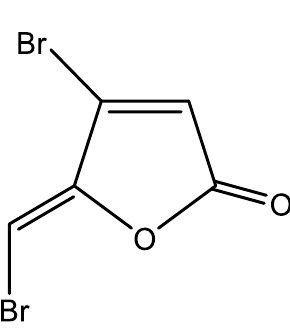
Figure 5. Chemical structure of the quorum sensing inhibitor, (Z-)-4-bromo-5-(bromomethylene)- 2(5H)-furanone.